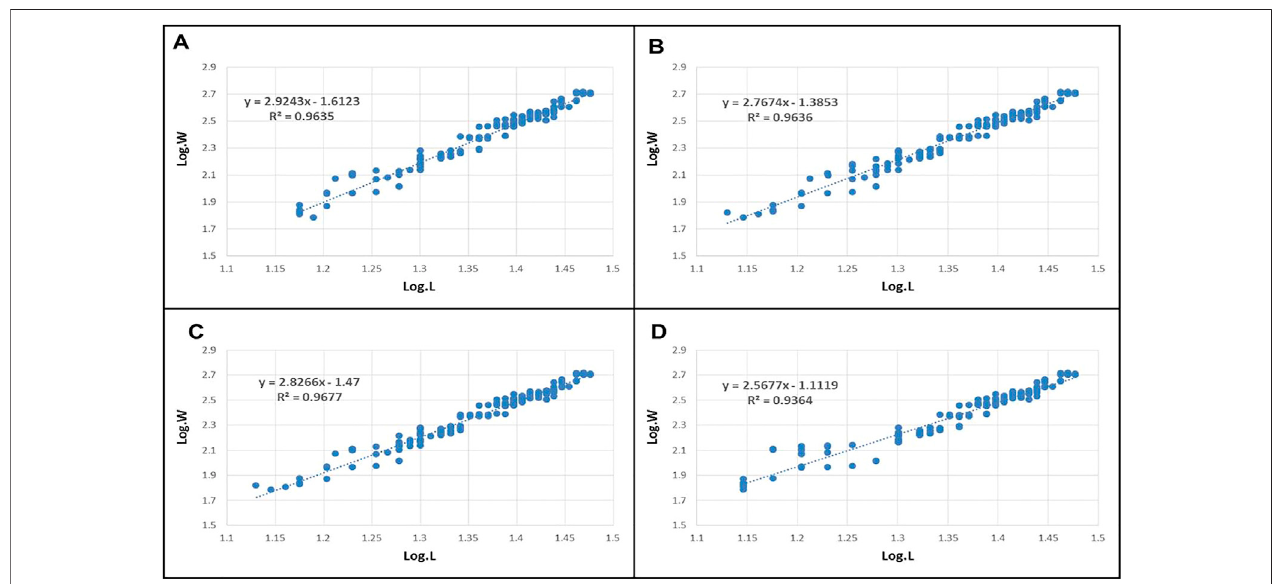
FIGURE 2 | Length-weight relationship of lake and farmed Nile Tilapia, O. niloticus . (A) : Non-infected farmed fi sh (B) : Infected farmed fi sh; (C) : Non-infected lake fi sh (D) : Infected lake fi sh.